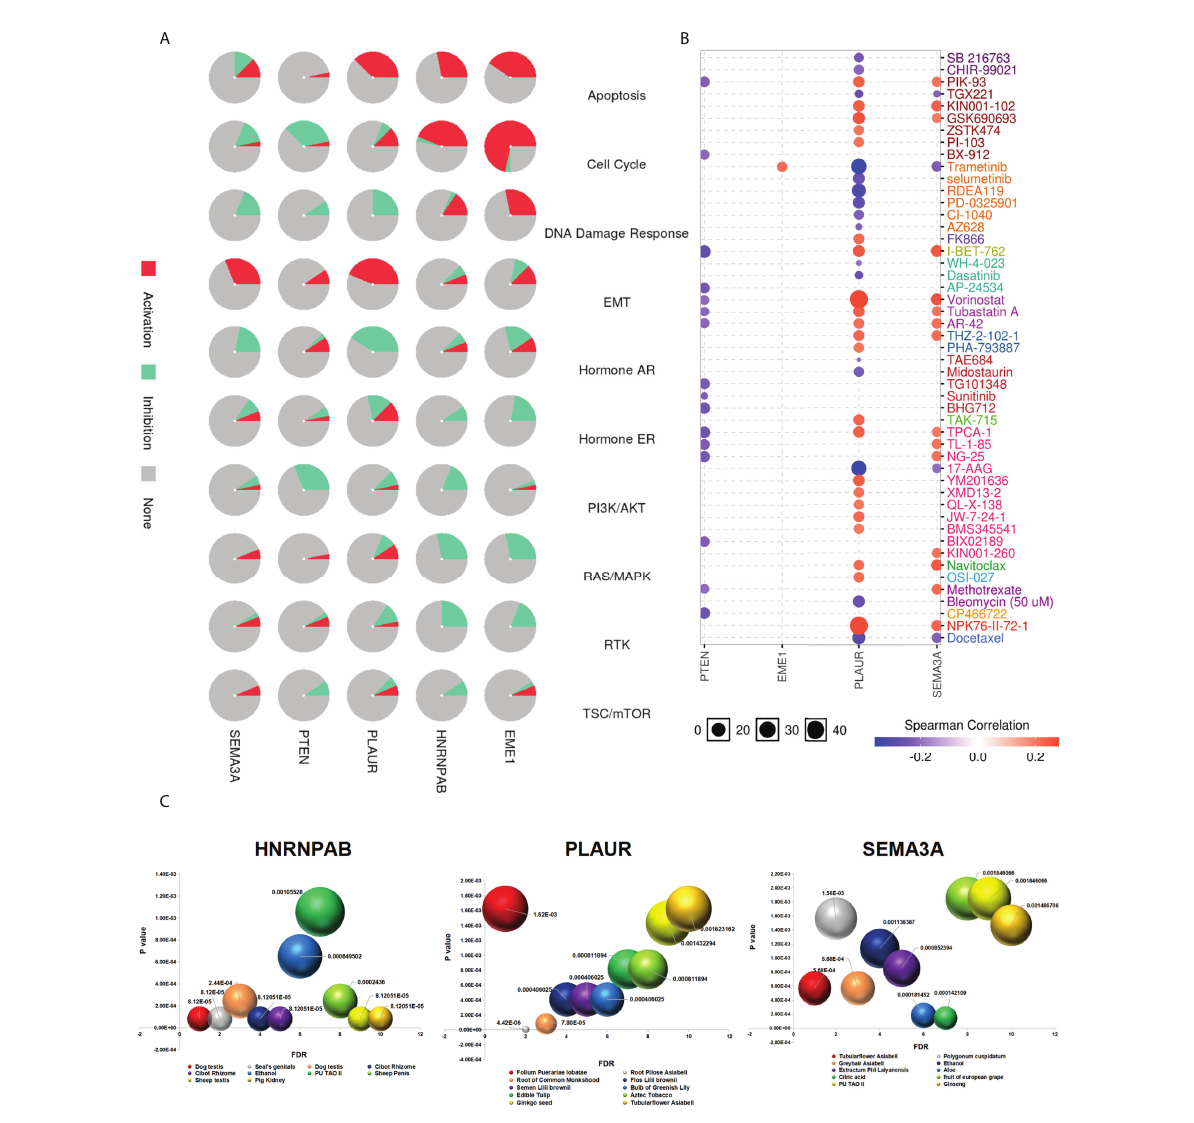
FIGURE 12 Drug sensitivity analysis. (A) The role of predicted target genes in cancer pathway activity in LUAD. (B) Drug sensitivity and gene expression data. (C) Chinese herbal medicines potentially target